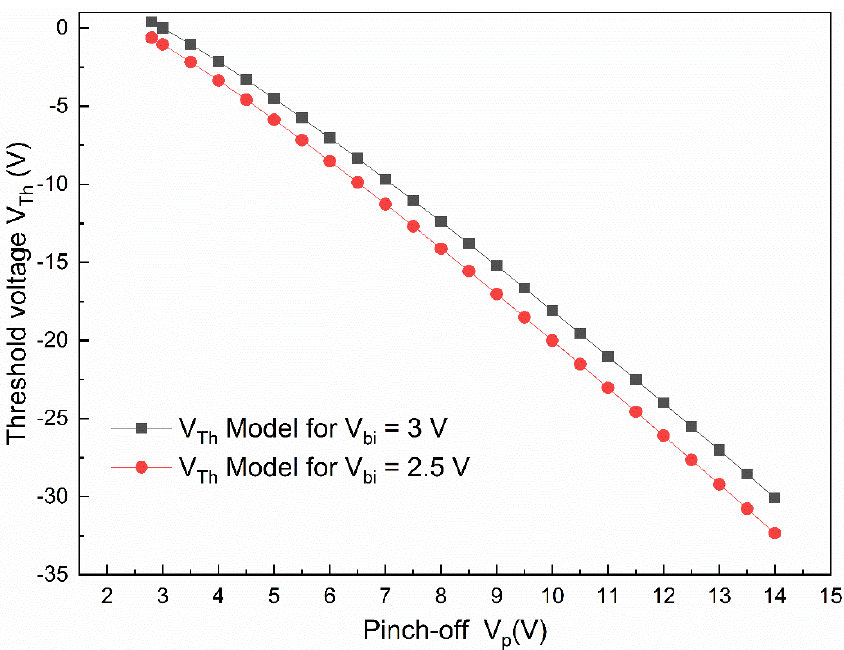
Figure 9. Graphical representation of threshold voltage model versus the Pinch-off voltage for two different values of V bi .